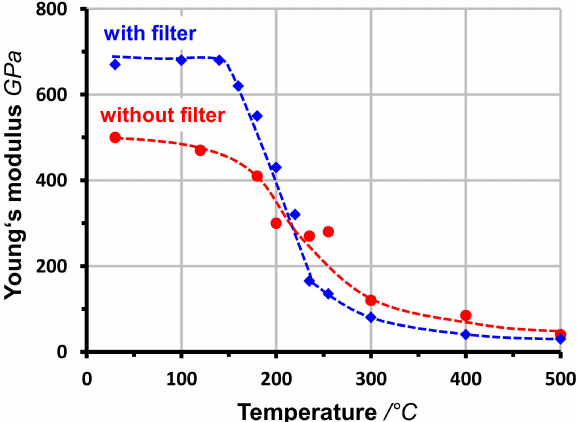
Figure 22. Dependence of the Young‘s modulus on the substrate temperature for carbon films prepared by Laser-Arc deposition without and with an additional filter unit